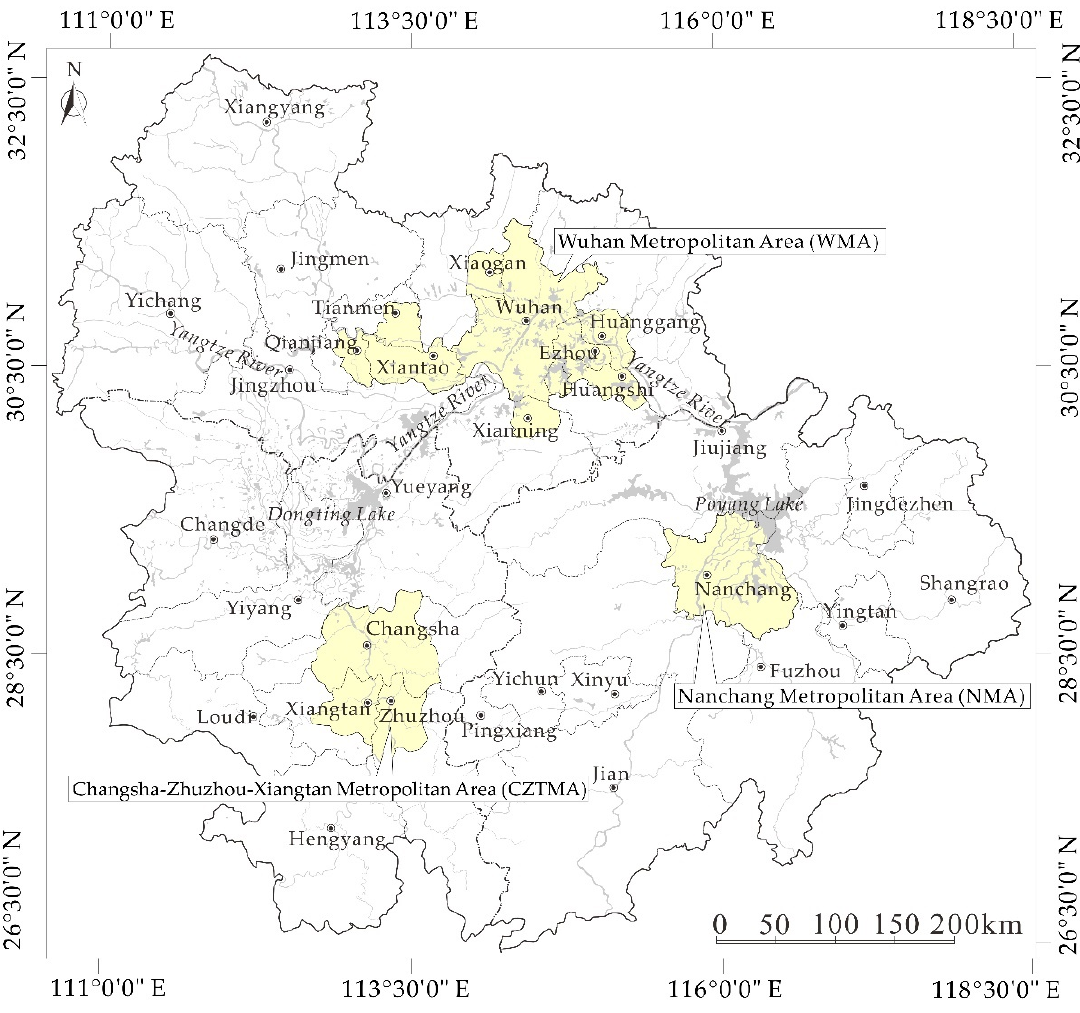
Figure 1. Scope and location of UAMRYR.